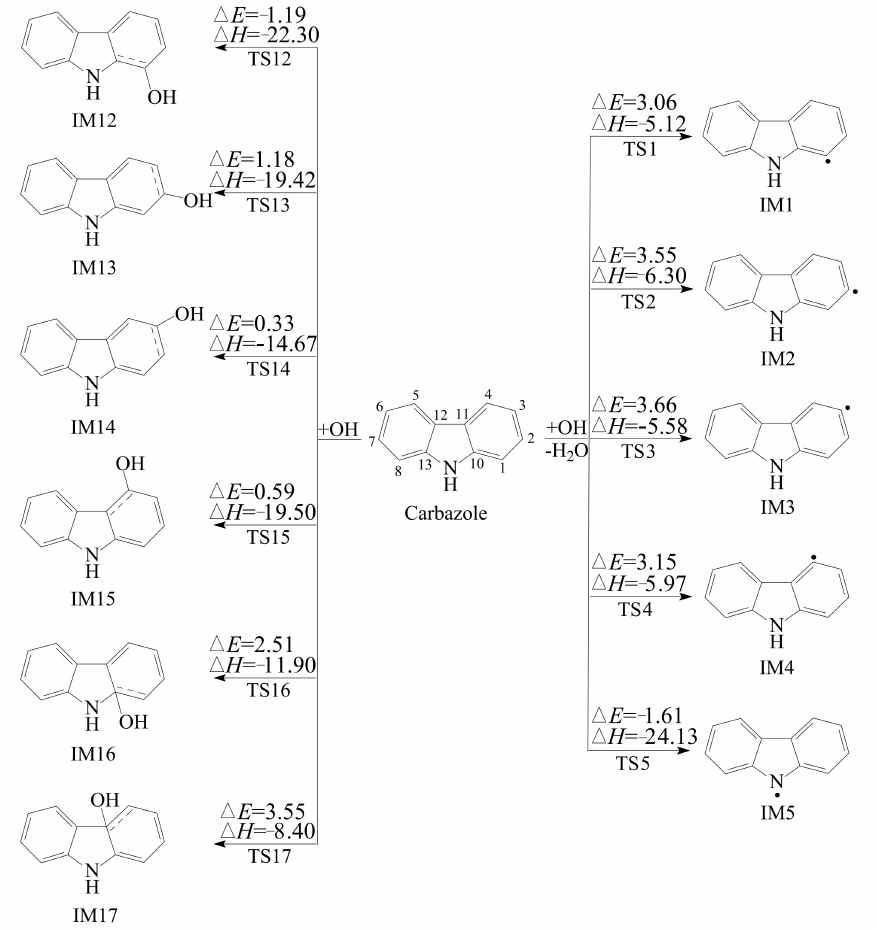
Figure 2. The OH addition and H abstraction reaction scheme of carbazole embedded with the potential barriers ∆ E (in kcal mol − 1 ) and reaction heats ∆ H (in kcal mol − 1 , 0 K). Nine H abstraction pathways of carbazole initiated by OH radical were identified: